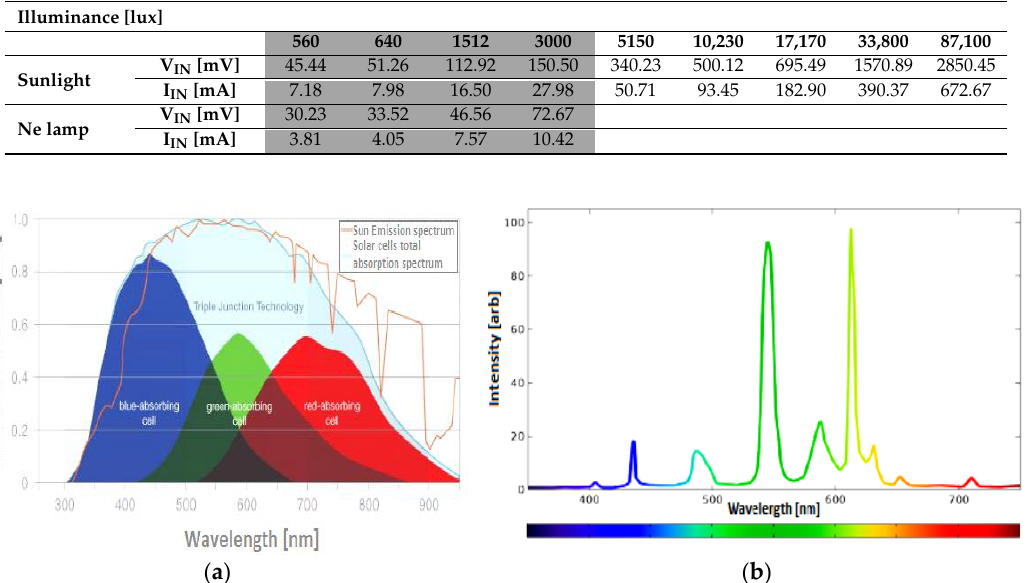
Figure 12. Solar emission spectrum and solar cells absorption spectrum ( a ); Ne lamp emission spectrum ( b ).